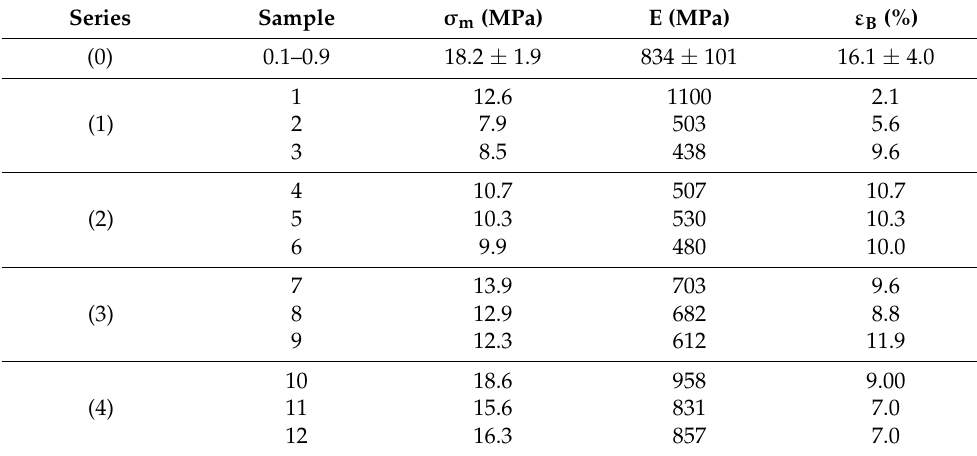
Table 4. Mechanical parameters of resin and composite